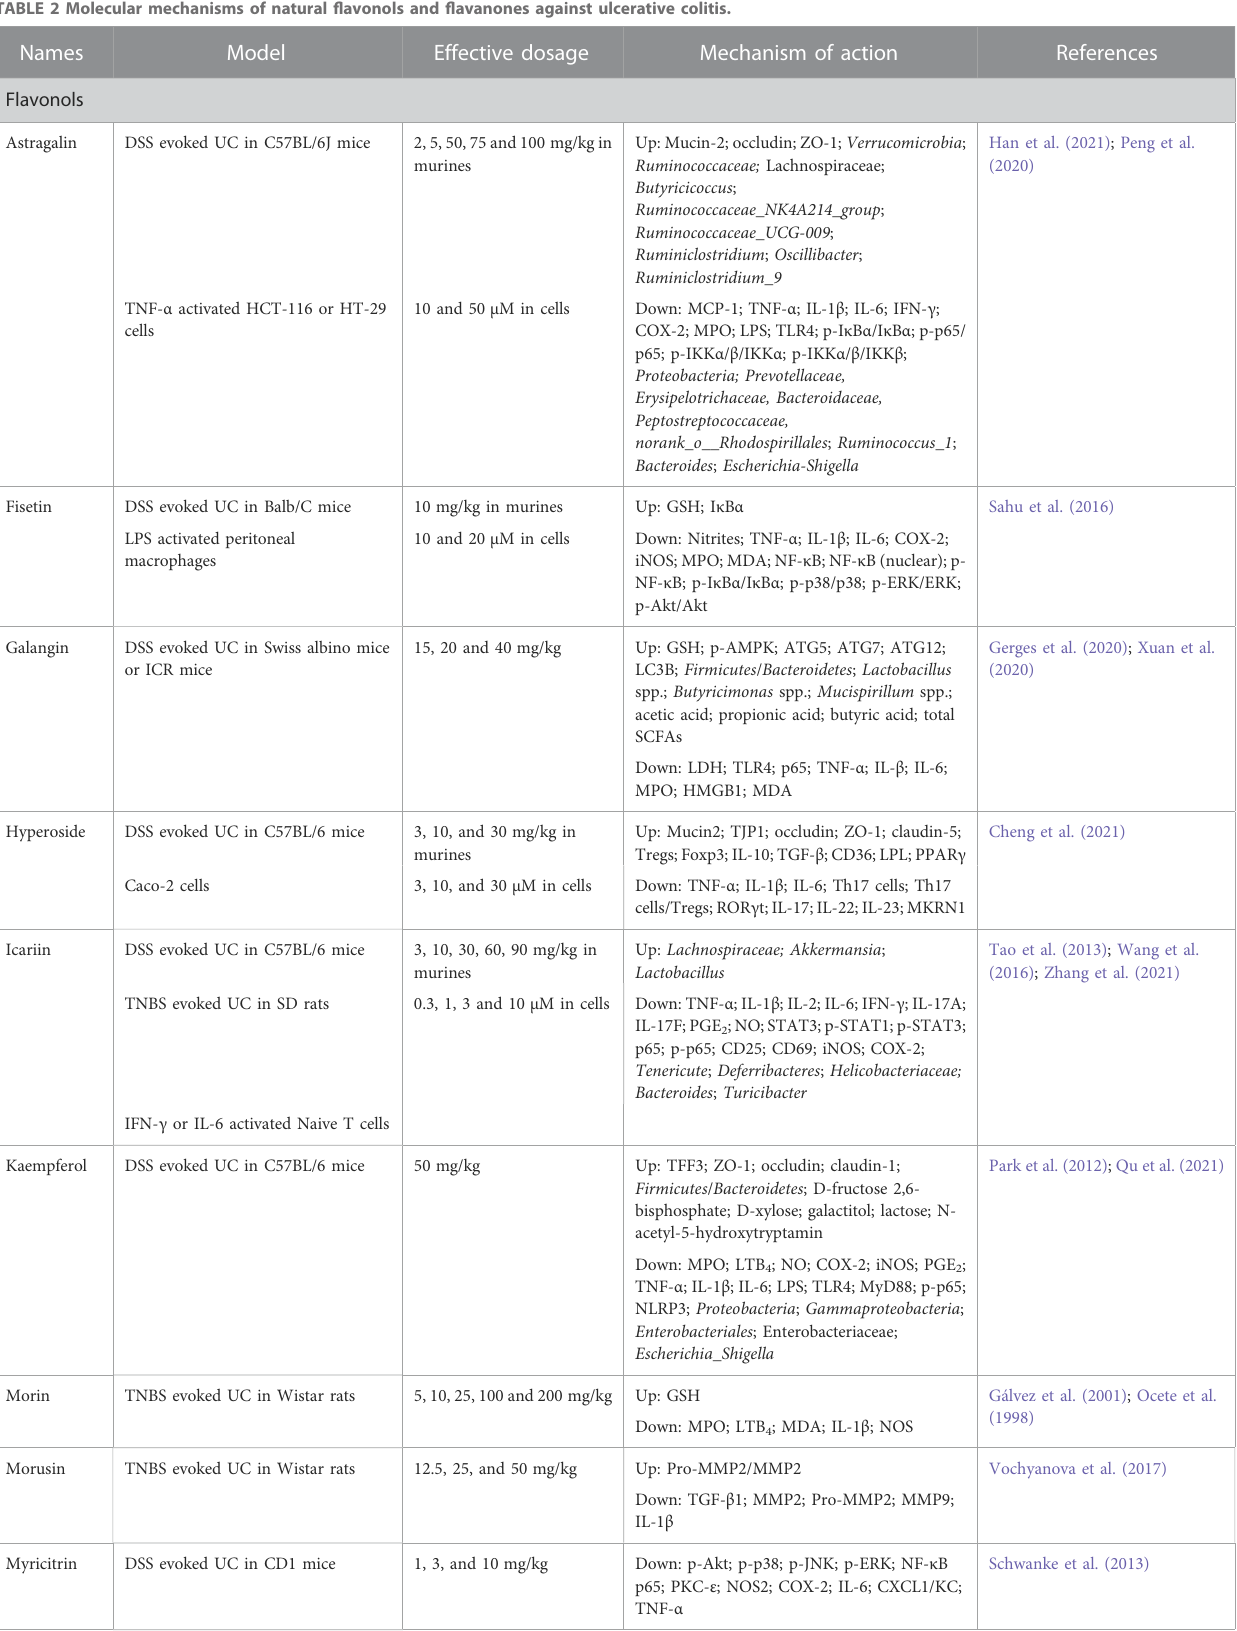
TABLE 2 Molecular mechanisms of natural fl avonols and fl avanones against ulcerative